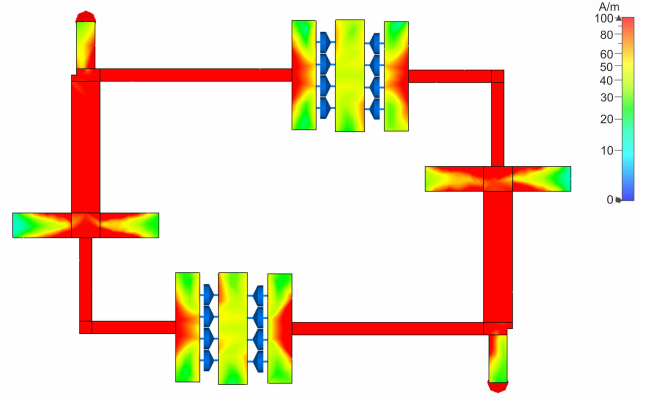
Figure 16. Exemplary current distribution at the centre frequency (566 MHz) of the filter.